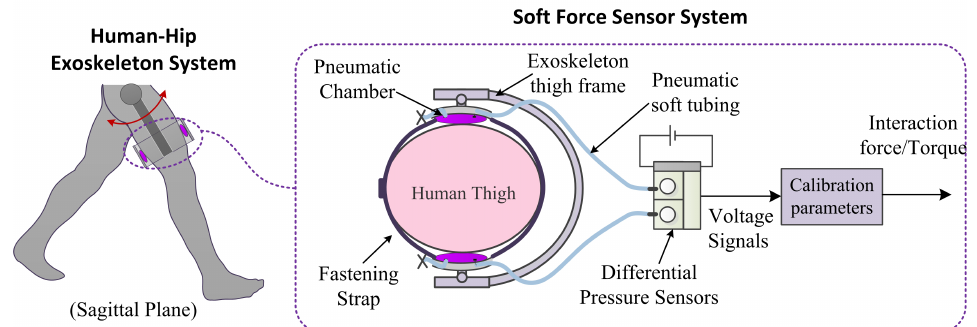
Figure 2. Overall schematic diagram of the developed soft force sensor system.